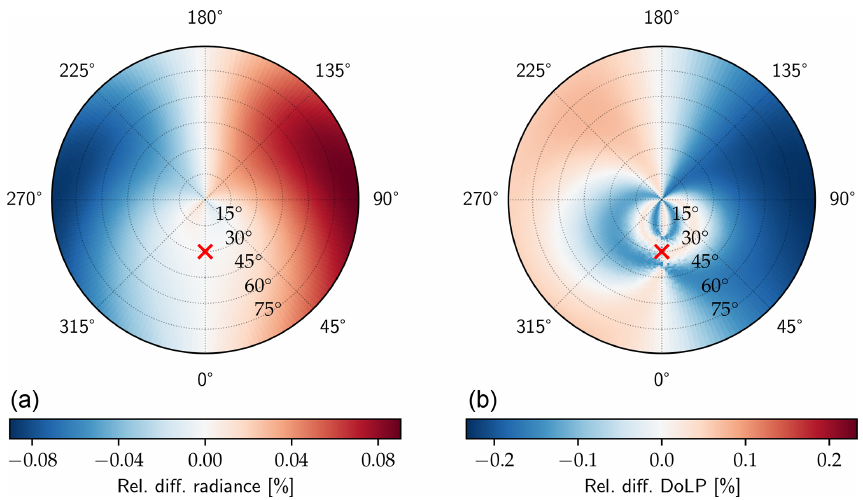
Figure 7. Relative difference in measured total radiance (a) and degree of linear polarization (b) at 500nm due to the remaining uncertainties in rotation of the polarizers after performing the described calibration. The setup and scene are the same as in Fig. 5.